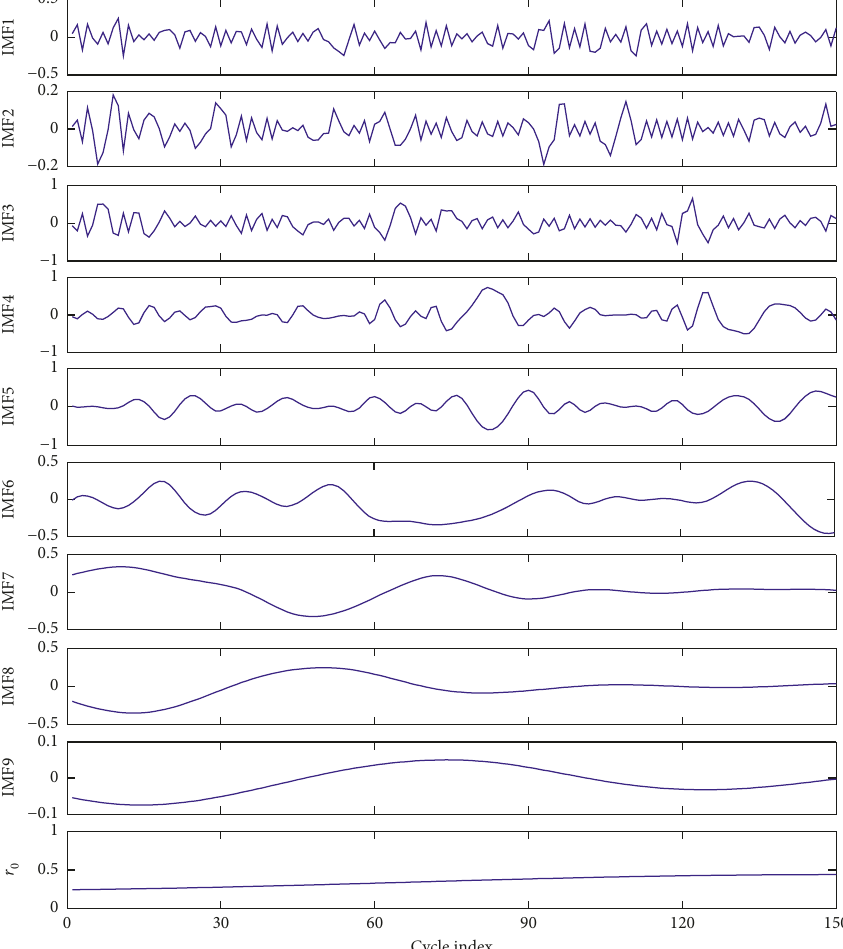
Figure 7: EMD results of the generated IDI series.